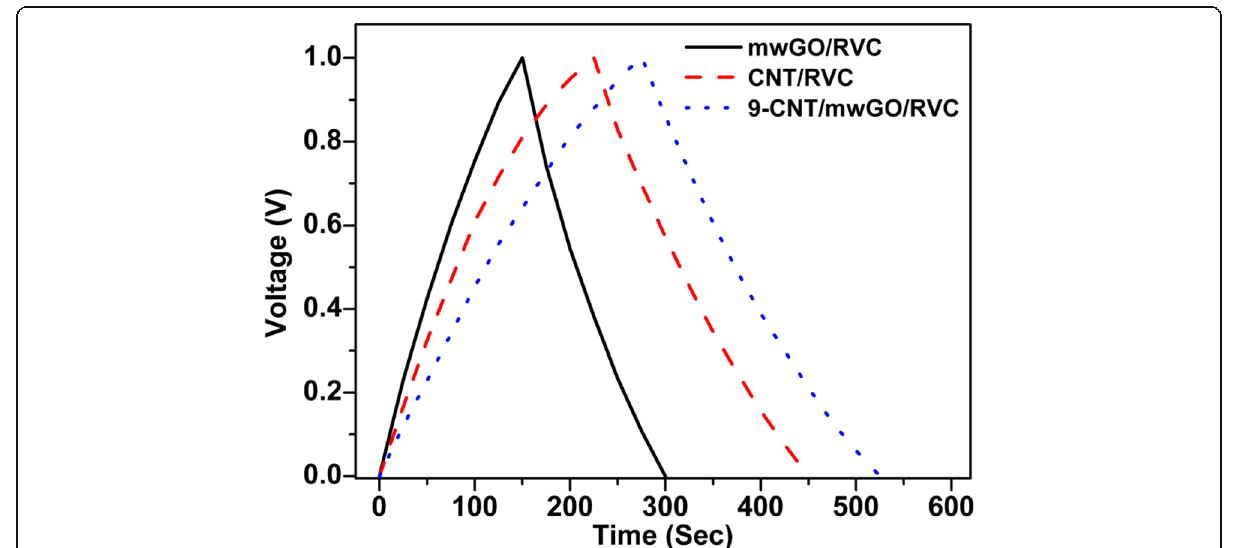
Fig. 6 Galvanostatic charge-discharge (GCD) process of mwGO/RVC, CNT/RVC, and 9-CNT/mwGO/RVC